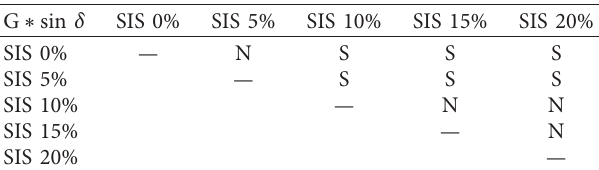
Table 4: Statistical analysis results of the G ∗ sin δ value as a function of SIS content.